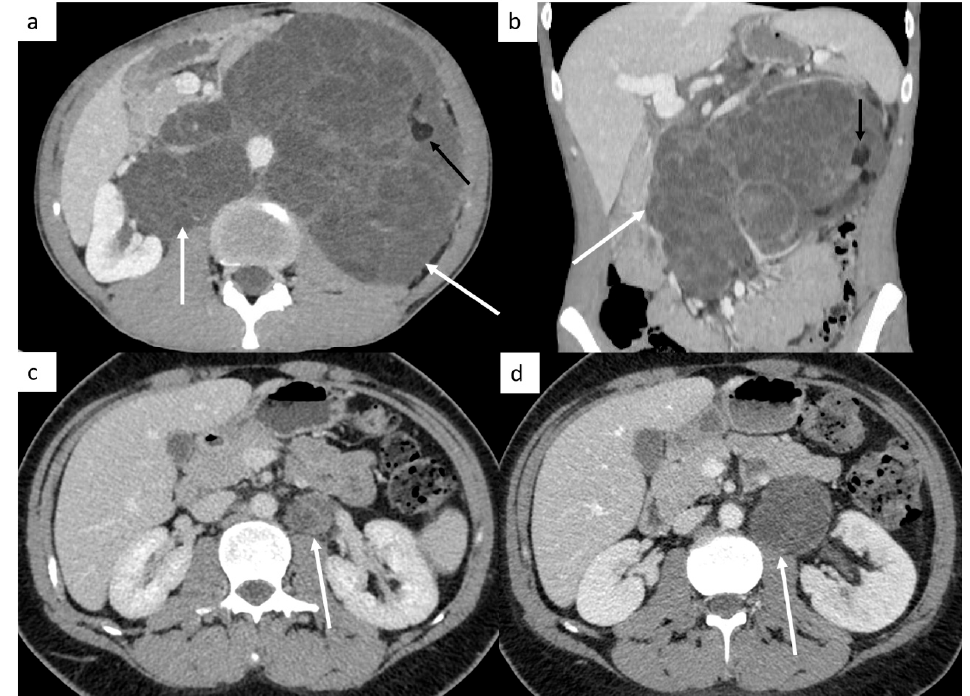
Figure 6. Teratoma and growing teratoma. Imaging in patient with a mature teratoma of the left testicle. Abdominal CT reveals a retroperitoneal mass ( a , b white arrows) with fat tissue ( a , b black arrows) corresponding to a teratoma. Abdominal CT shows a left paraaortic lymph node ( c ) with an increasing size during chemotherapy with classical features of growing teratoma: better circumscribed margins, expanding cystic and necrotic appearance of the lesion ( d ).